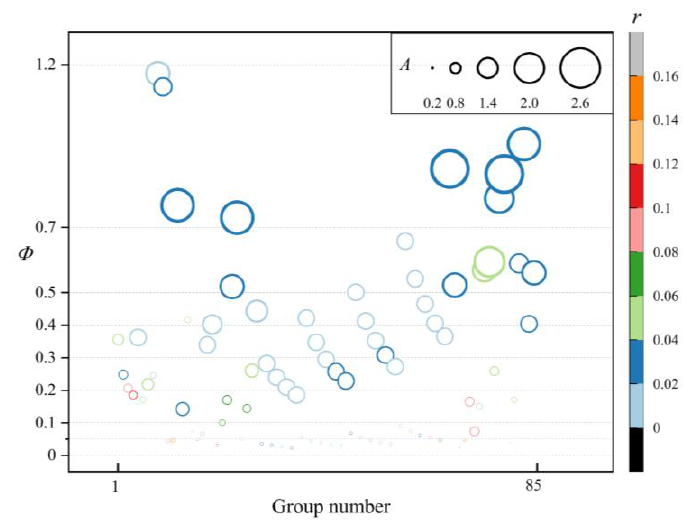
Figure 10. The error between the exact solution and the approximate solution.